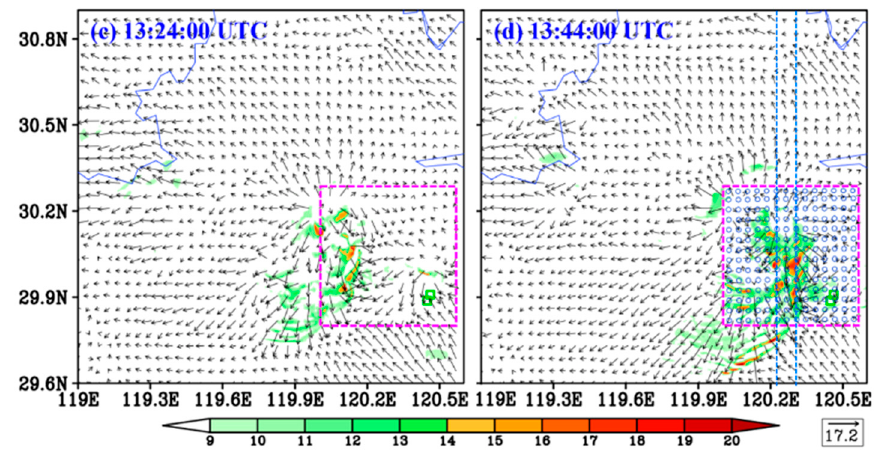
Figure 7. Panels ( a – d ) show the simulated surface wind speed (shading; m s − 1 ) and vector (arrows; m s − 1 ) at typical stages of the event. The dashed purple box marks the regions where the downburst appeared, the small blue open circles show the locations for backward tracking, the small green boxes mark the locations at which the tower toppling appeared, and the two dashed lines mark the band (from 120.24° E to 120.32° E) for calculating the averaged cross section.